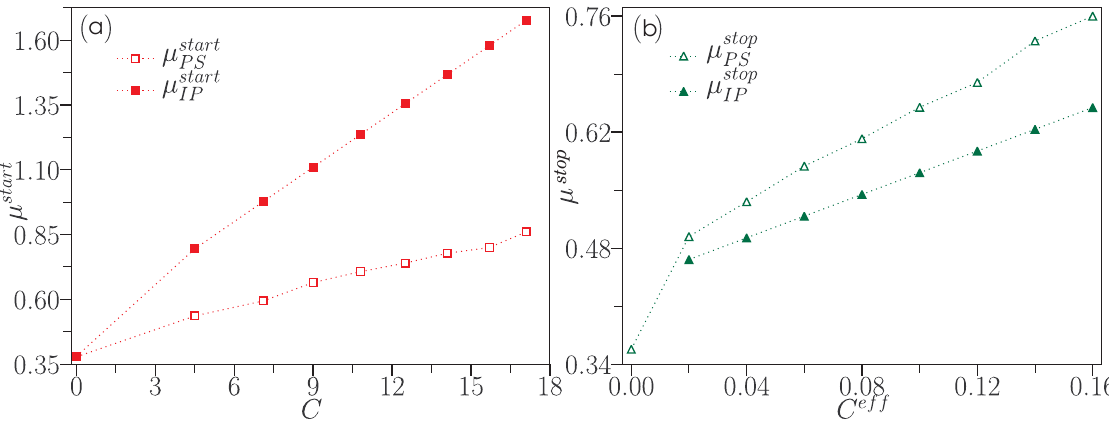
Figure 4. (a) Starting friction coe ffi cient as a function of the cohesion number C and (b) stopping friction coe ffi cient as a function of the e ff ective cohesion number C ef f for both the inclined plane (IP) and plane shear (PS) configurations.